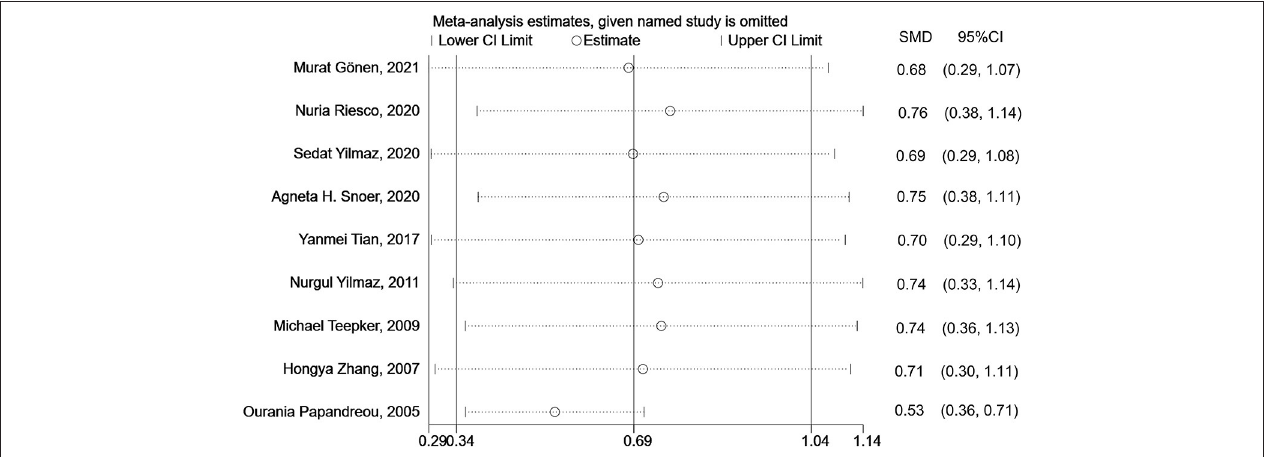
FIGURE 4 | Sensitivity analysis for the association between S100B levels and overall migraine. SMD, standardized mean difference; CI, confidence interval.